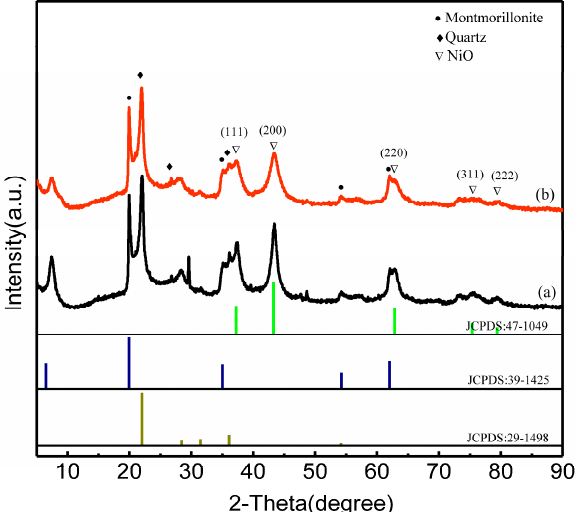
Figure 3. XRD patterns of the Ni/Bentonite-U (a) and Ni-2wt%Mn/Bentonite-U (b) after being calcined at 400 °C.